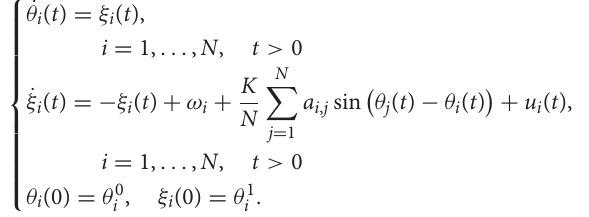
FIGURE 10 | Control function oscillators, K > K * and interactions as in Figure 8